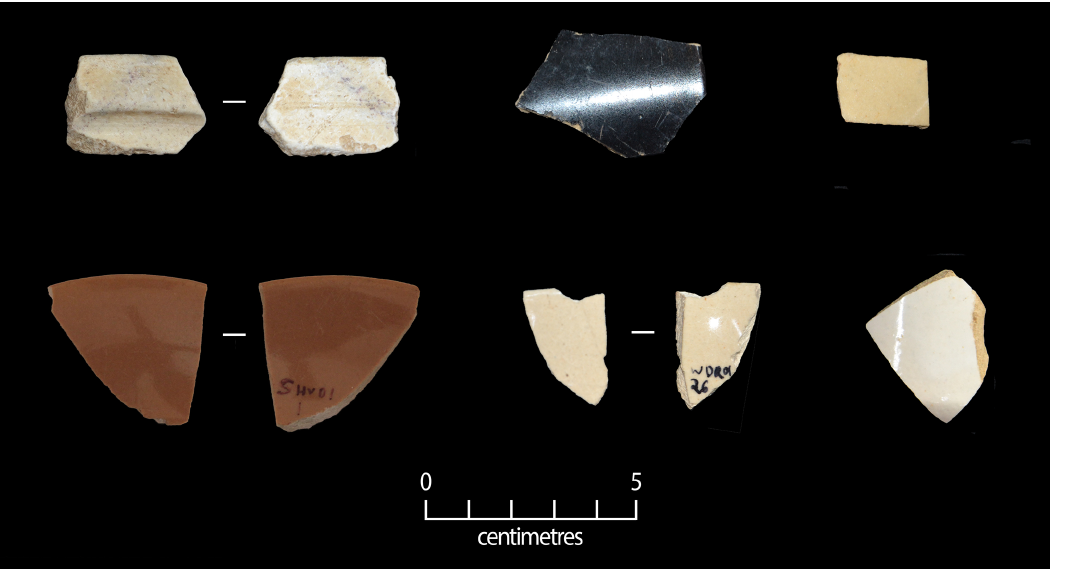
Figure 35: Examples of Class 12 body